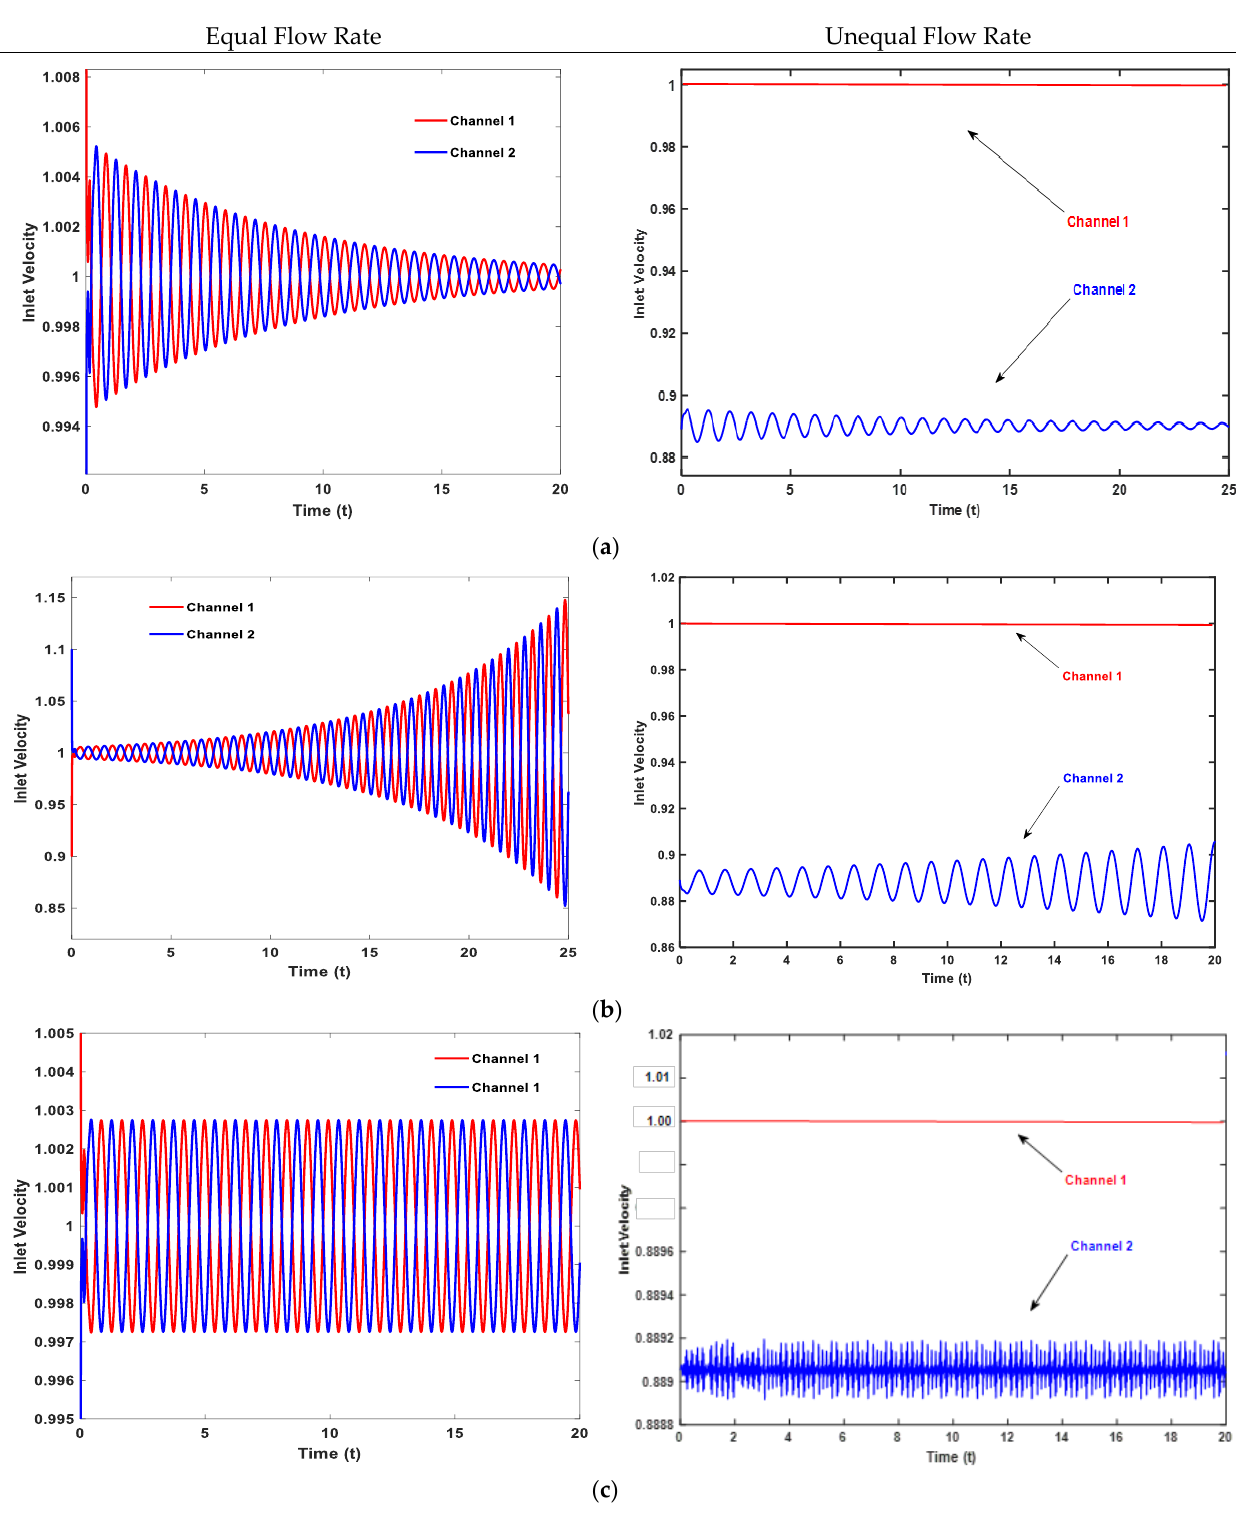
Figure 10. Numerical simulation of the inlet velocity around different locations corresponding to Figure 8. ( a ) on the stable side; ( b ) on the unstable side; ( c ) on the stability boundary.